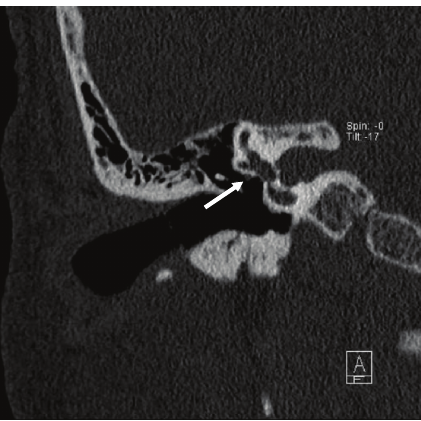
Figure 6: Facial nerve dehiscence. Coronal CT image of right temporal bone demonstrates dehiscence of right CN VII tympanic segment at the level of oval window